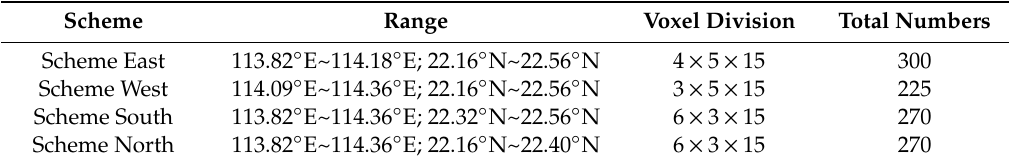
Table 2. The range of the tomographic area and the number of voxels in the four schemes.